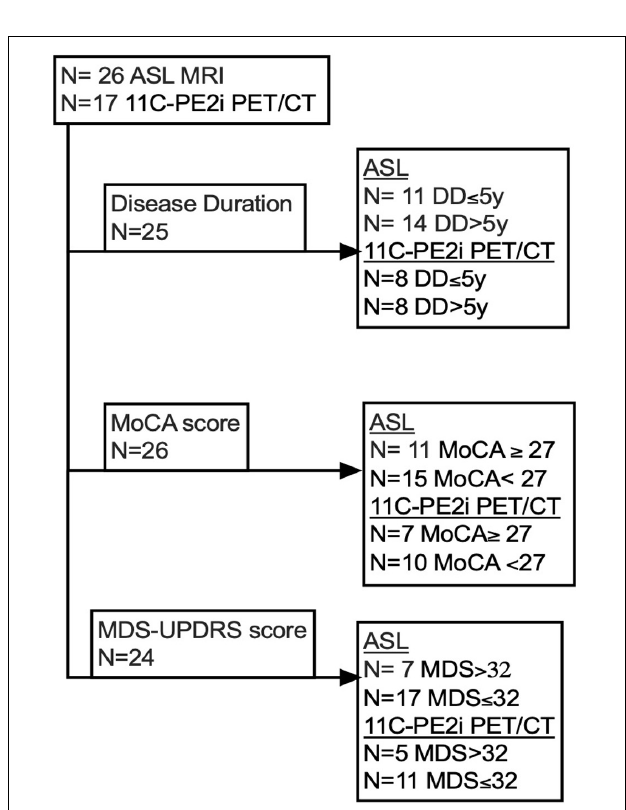
FIGURE 2 | Stratification of the study cohort into subgroups based on clinical characteristics.